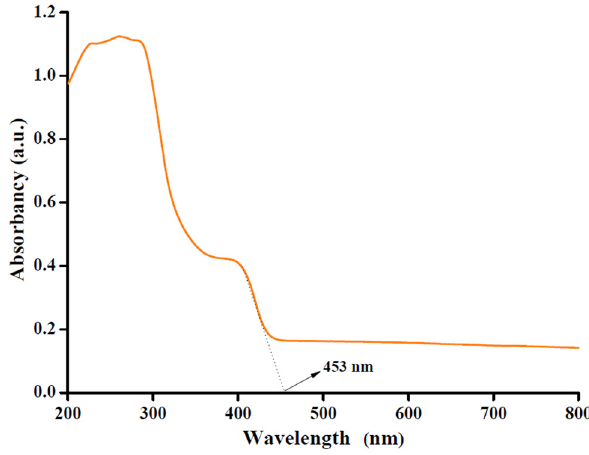
Figure 5: UV - Vis light DRS of Bi 2 O 3 @Zn - MOF - 2